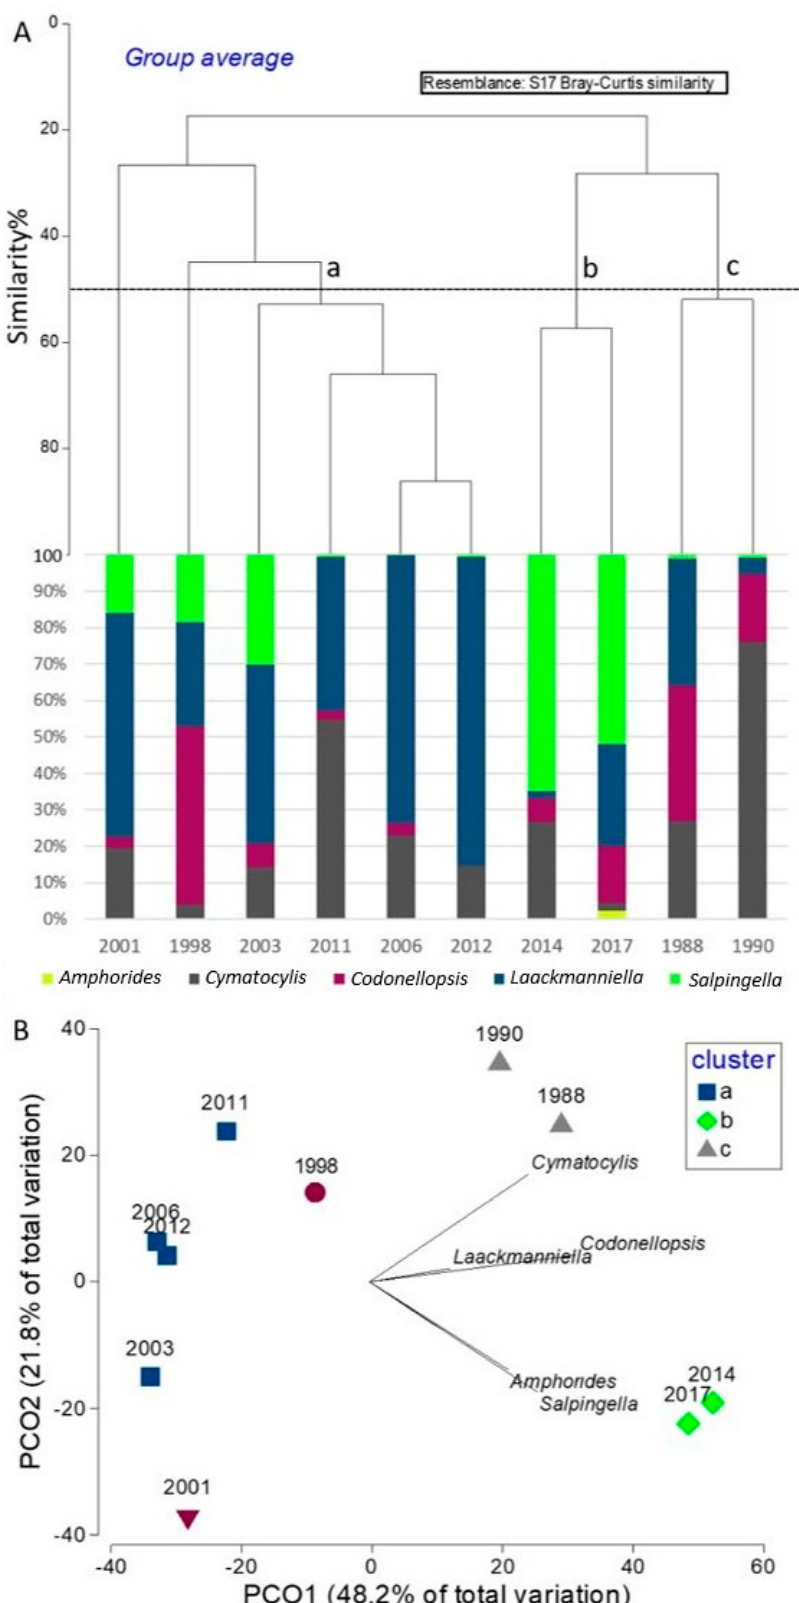
Figure 9. Community composition and similarity recorded during years, cluster analysis ( A ) and PCO ( B ) were performed on Bray-Curtis similarity matrix.